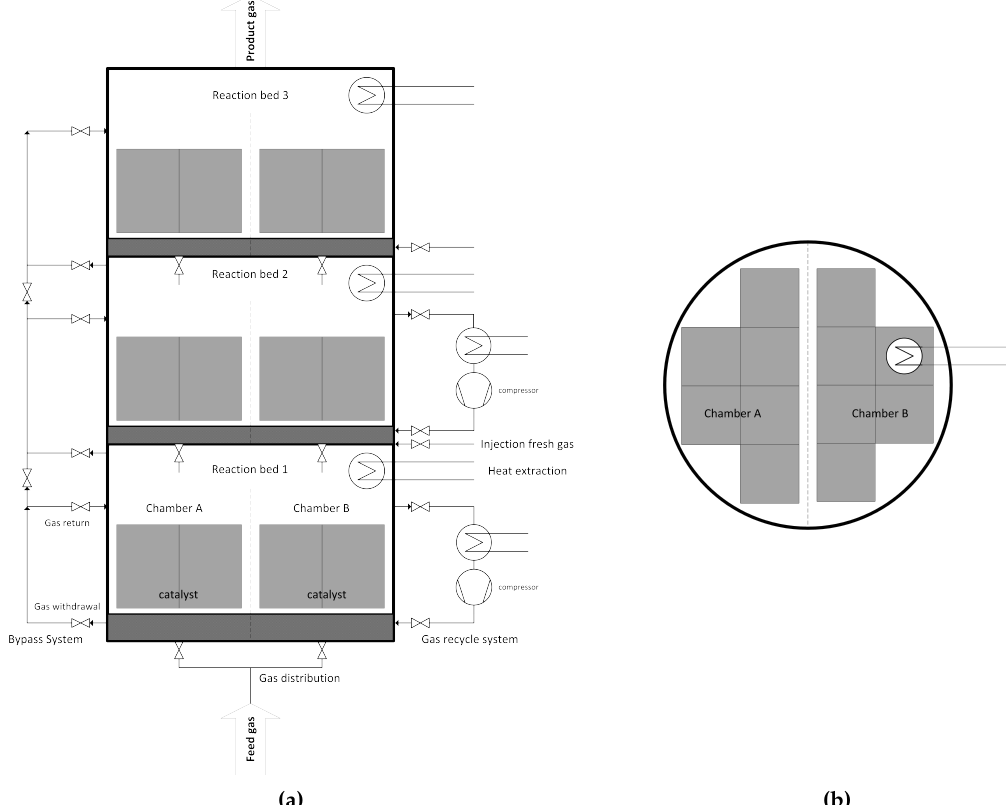
Figure 2. Simplified scheme of a multi bed reactor with three beds and two chambers [23]; ( a ) elevation; ( b ) floor